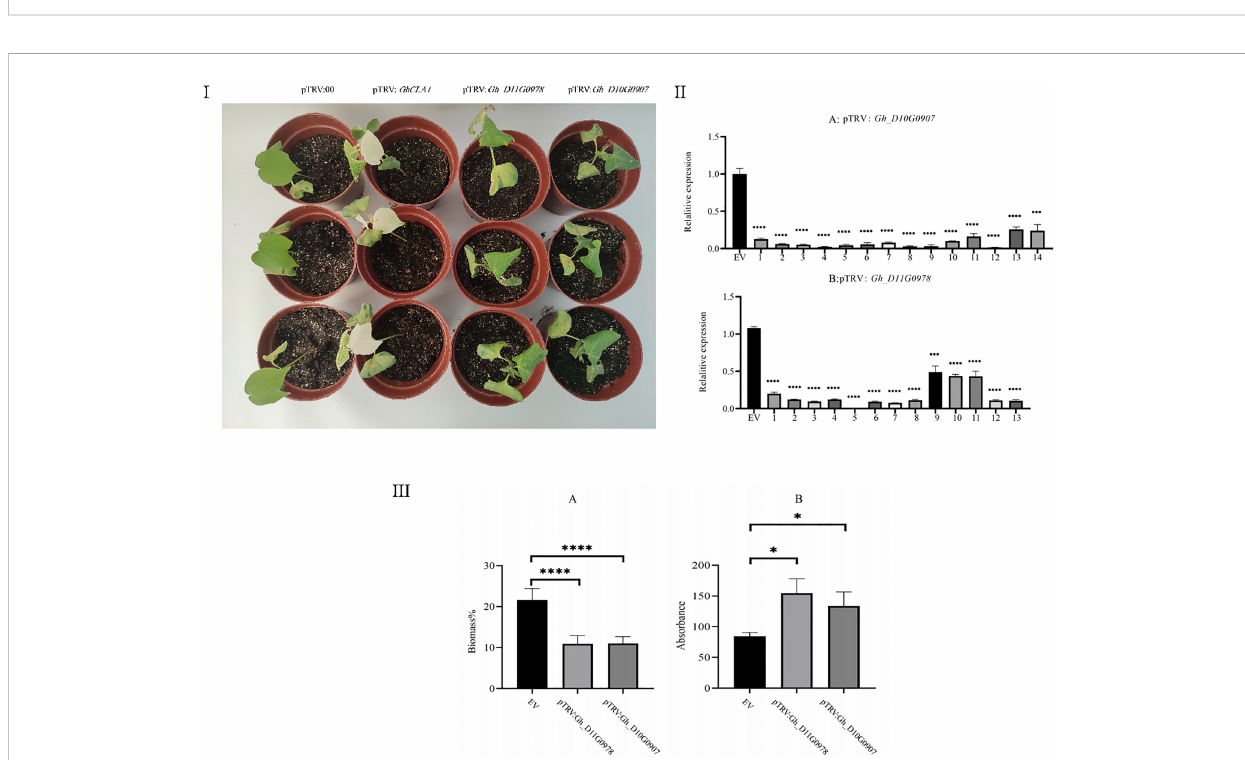
FIGURE 4 I : Phenotype of VIGS plants after 7 d of salt treatment. In the fi gure from left to right are pTRV:00 (negative control, empty vector), pTRV : GhCLA1 (positive control, silencing the GhCLA1 gene), pTRV : Gh_D11G0978 (silencing the Gh_D11G0978 gene), and pTRV : Gh_D10G0907 (silencing the Gh_D10G0907 gene). II : (A) : Gene expression of pTRV : Gh_D10G0907 -silenced cotton. (B) : Gene expression of pTRV : Gh_D11G0978 -silenced cotton. III : (A) : Comparison of the biomass ratio of roots and stems in the negative control, pTRV : Gh_D10G0907 , and pTRV : Gh_D11G0978 . (B) : Comparison of the ROS content of leaves in the negative control, pTRV : Gh_D10G0907 , and pTRV : Gh_D11G0978